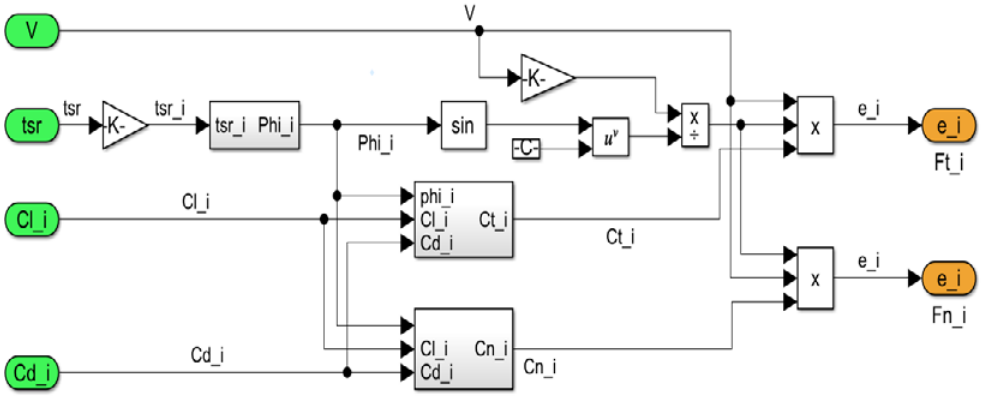
Figure 8. Aerodynamic load model in MATLAB/Simulink.